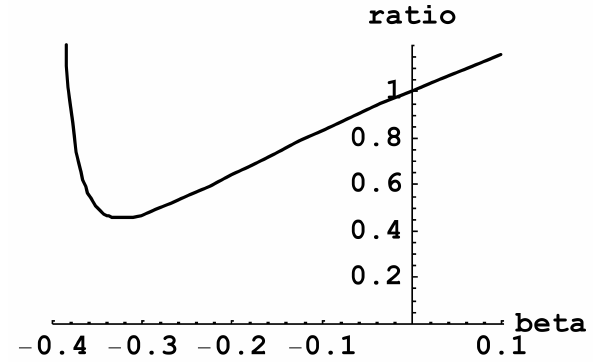
Figure 1. Ratio of the energy shift due to the ellipsoid-shaped nucleus to the energy shift due to the corresponding spherical nucleus versus the parameter β , characterizing the degree of non-sphericity of the nucleus.